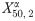
Family X50,2α with α = 1, 2, …, 101.CEN, MCEN, ACC* and MCC* as function of α.